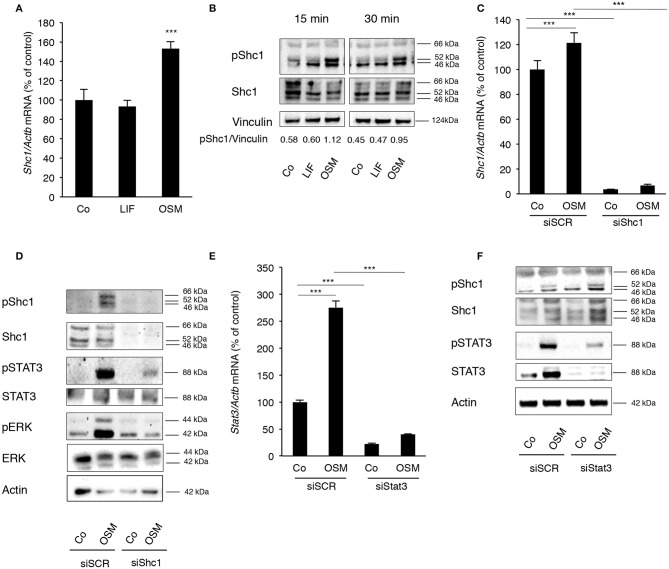
OSM stimulates activation of STAT3 and ERK by phosphorylating the adapter protein Shc1. (A) Mouse calvarial osteoblasts were cultured in the absence (Co) or presence of LIF or OSM (both at 100 ng/mL) for 24 h and RNA was extracted for RT-qPCR analysis of Shc1mRNA. (B) The cells were exposed to LIF or OSM at 100 ng/mL for 15 and 30 min followed by cell lysis and Western blot for phosphorylated Shc1; the bands were quantified and normalized by vinculin. (C) Calvarial osteoblasts had the Shc1 gene silenced by small interfering RNA and were exposed to LIF or OSM (both at 100 ng/mL) for 24 h before RNA extraction and analysis of Shc1 mRNA expression by RT-qPCR; a scrambled sequence (siSCR) served as control. (D) Osteoblasts that had the Shc1gene knocked-down by siRNA and control cells exposed to scrambled sequence (siSCR) were exposed to OSM at 100 ng/mL or vehicle for 15 min and proteins were extracted for analysis of the phosphorylation of Shc1, STAT3 and ERK. (E) The Stat3 gene was silenced in calvarial osteoblasts, which were subsequently exposed to OSM at 100 ng/mL or vehicle (Co) for 24 h before analysis of Stat3 gene expression by RT-qPCR. (F) The effect of Stat3 silencing on phosphorylation of STAT3 and Shc1 was analyzed by Western blot in osteoblasts treated with OSM for 15 min. (A,C,E) Values represent means for four wells and SEM is shown as vertical bars. (A) Significant differences compared to untreated cells (Co) at each time point are defined as ***P < 0.001; analyzed by one-way ANOVA followed by Dunnet's post hoc-test. (C,E) Significant differences are indicated by horizontal lines where ***P < 0.001 two-way ANOVA followed by Tukey post hoc-test. The difference in OSM-induced response with and without silencing analyzed by two-way ANOVA was statistically significant [interaction P-value in C (P < 0.005) and in E (P < 0.0001)]. OSM had no statistically significant effect (P > 0.05) on Shc1 or Stat3 mRNA expression in cells which had been silenced for Shc1 or Stat3, respectively (C,E).